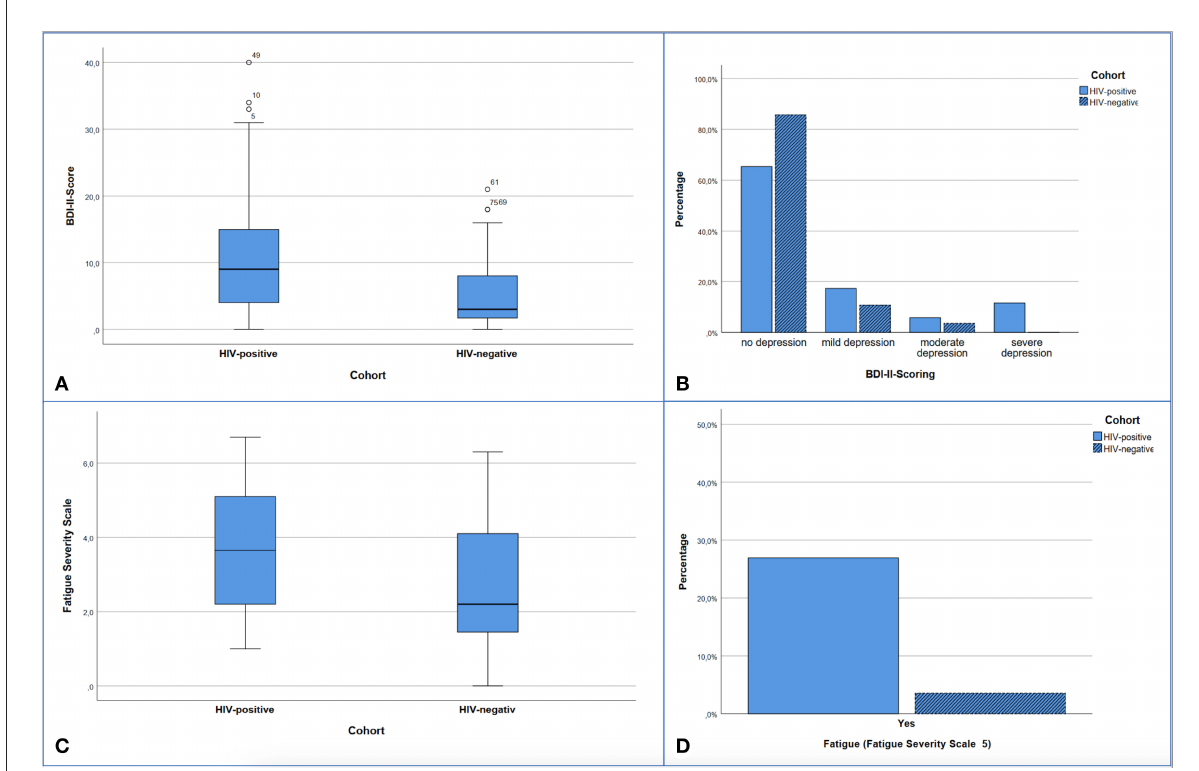
FIGURE3 Presentation of screening results for depression (A,B) and fatigue (C,D) . (A) Significant difference with p < 0.005 in median comparison of BDI-II Scores: HIV-positive 9.0 (Min 0; Max 40.0) vs. HIV-negative 3.0 (Min 0; Max 21.0). (B) Distribution of depression levels according to the BDI-II within the cohorts. 14.3% of the control subjects and 34.6% of the HIV subjects showed depressive symptoms (cut-off 13.0 points). 0- − 12 no depression or clinically unremarkable, 13–19 mild depressive syndrome, 20–28 moderate depressive syndrome, > 29 severe depressive syndrome. Significant difference in Mann-Whitney-U-test with p = 0.040. (C) FSS points comparing both cohorts, significant difference with p = 0.013 in median comparison: HIV-positive: 3.65 (Min 1.0; Max 6.7) vs. HIV-negative 2.20 (Min 0; Max 6.3). (D) Proportion of subjects within the cohorts with fatigue detected in the FSS (cut-off > 5), significant difference with p = 0.028 by Chi-square